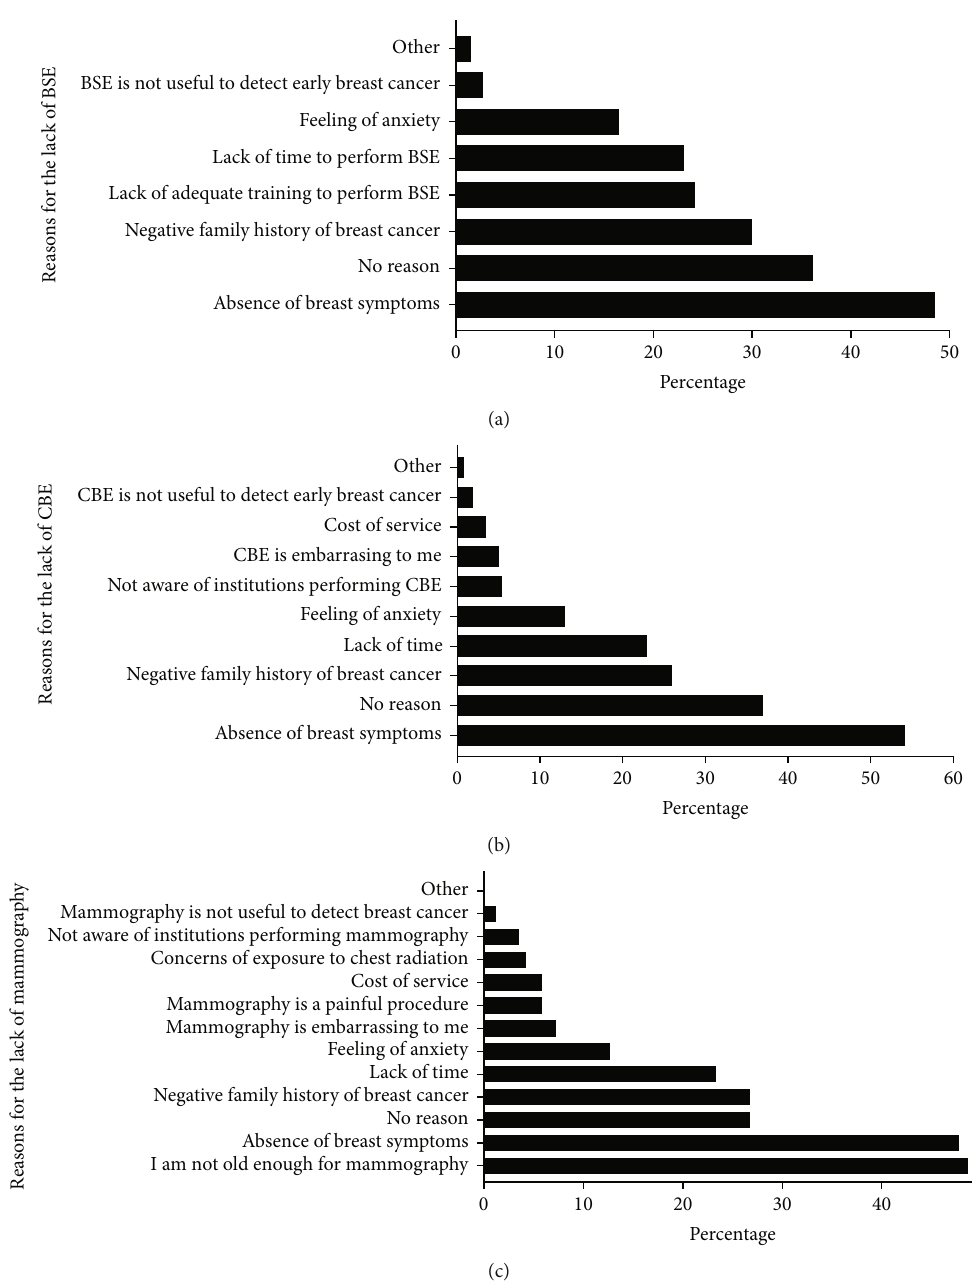
Figure 3: Reasons for the lack of performance for the di ff erent screening methods for the early detection of breast cancer among community